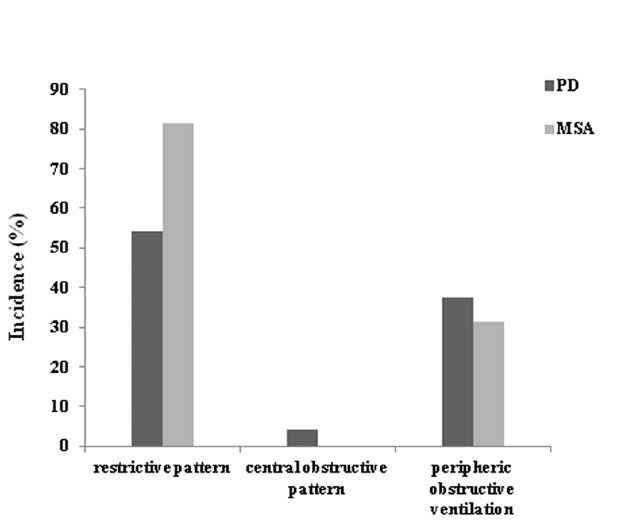
Fig. 1. The mean percentage of predicted values of (A) lung volume, (B) spirometry and (C) diffusion capacity and respiratory muscle strength in Parkinson’s disease (PD), multiple system atrophy (MSA) and healthy controls (Ctrl). Asterisks indicate statistically significant differences between any of two groups on one-way ANOVA followed by the LSD procedure. Statistic threshold: *P , 0.05, ** 5 P , 0.001.